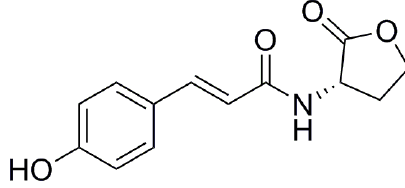
Figure 3. Structure of p -coumaroyl-HSL based on reference Schaefer et al.